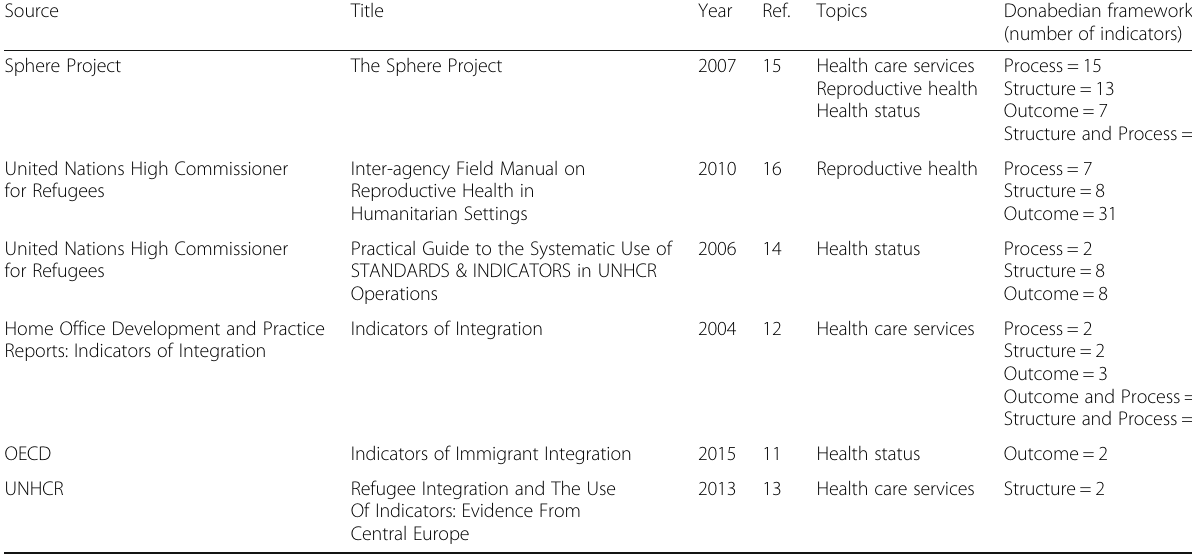
Table 1 Overview of the number of indicators related to health and health care of refugees